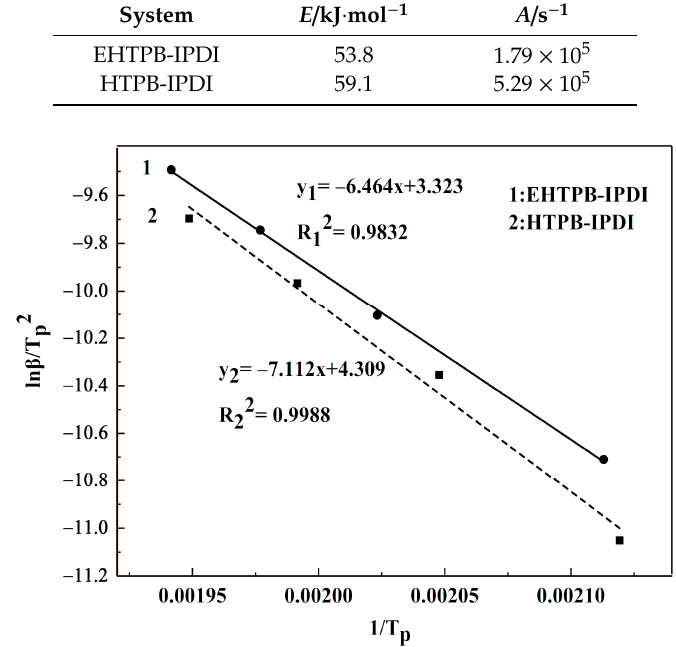
Table 2. Kinetic parameters of the curing reactions of the EHTPB-IPDI and HTPB-IPDI systems .